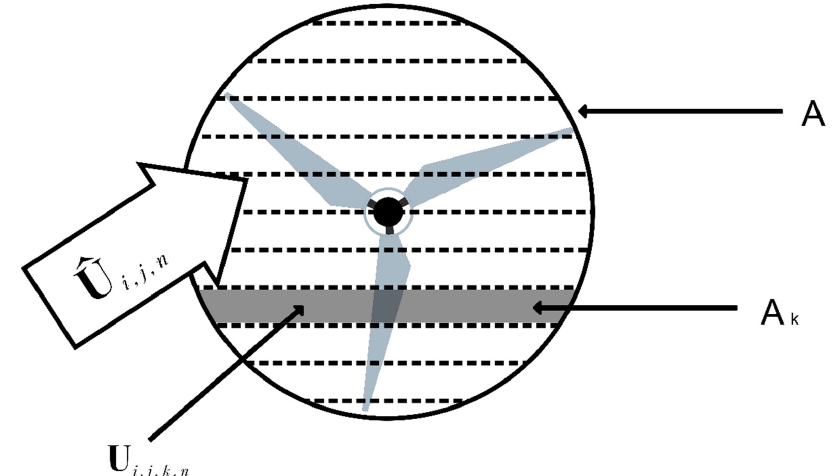
Figure 4. Power-weighted current velocity calculation across the projected captured area illustration. Here, k is considered as index number of the current profiler bin across the projected captured